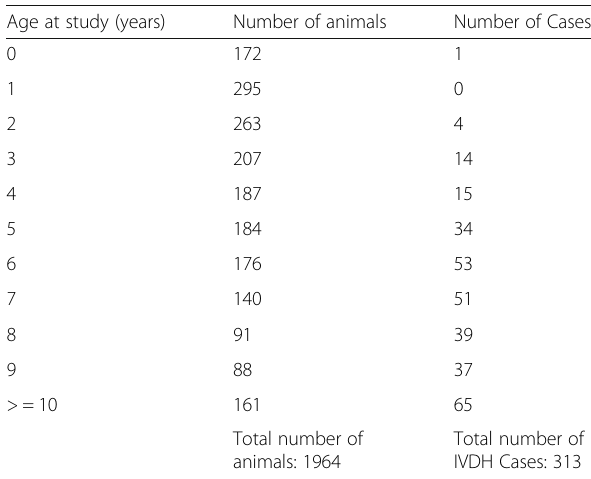
Table 3 Age distribution of the 1964 participants at the time of the questionnaire